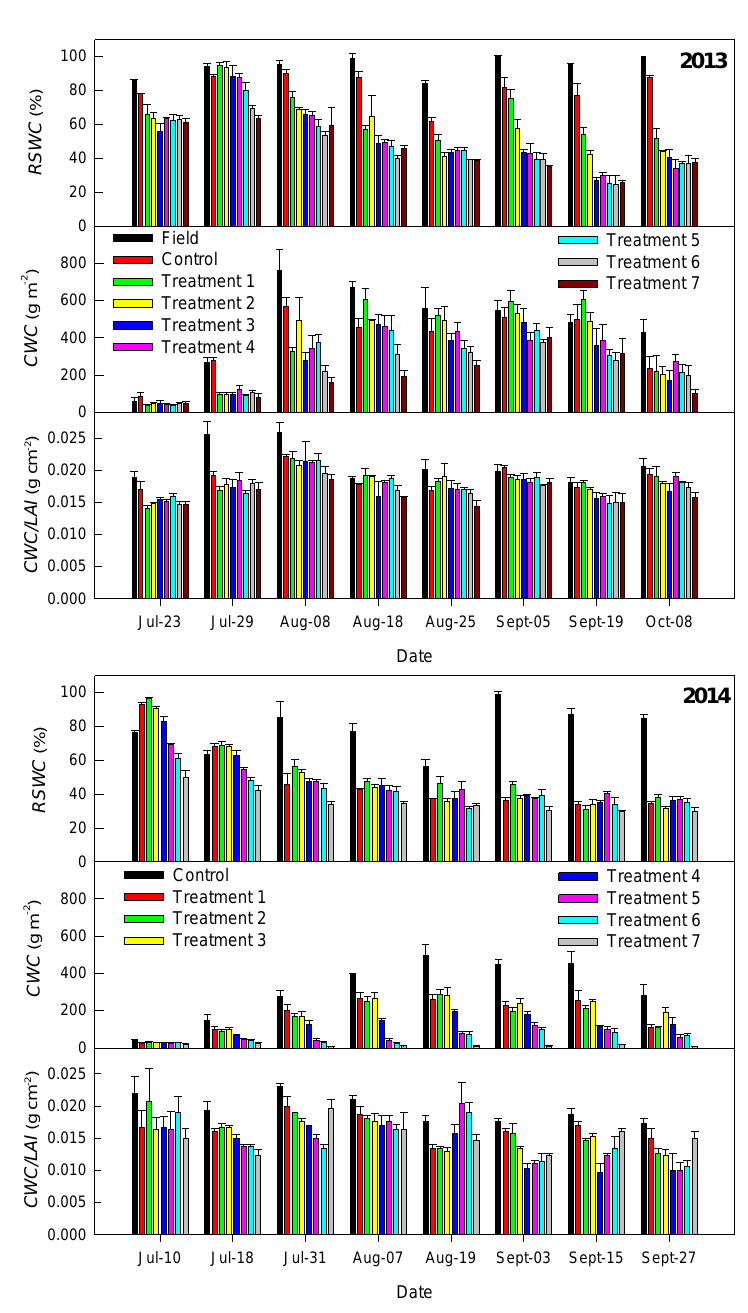
Figure 2. Variations in relative soil water content ( RSWC , %), canopy water content ( CWC , g∙m −2 ) and mean leaf equivalent water thickness at the canopy level ( 𝐸𝑊𝑇̅̅̅̅̅̅̅ , i.e. , CWC /leaf area index ( LAI ), g∙cm −2 ) during the growing seasons of 2013 and 2014. Error bars indicate the mean standard errors of three replicates. For 2013, treatments 1–7 indicate seven different irrigation amounts, 120, 100, 80, 60, 40, 25, and 15 mm, as well as a rainfed plot control with no irrigation (Control) and a rainfed field control (Field); for 2014, treatments 1–7 indicate different irrigation amounts of 225, 150, 120, 90, 60, 30, and 10 mm and the rainfed plot control with no irrigation